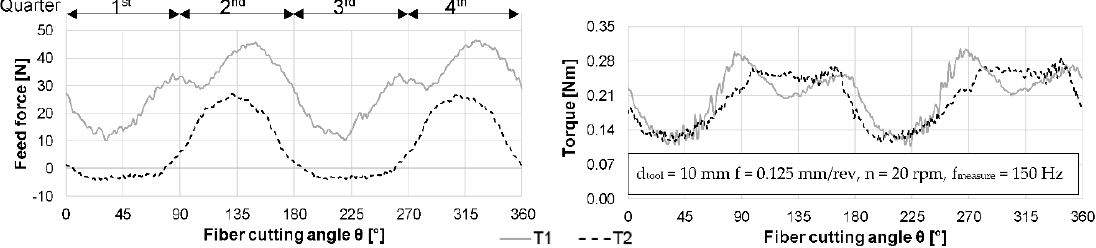
Figure 2. Comparison of feed force ( left ) and torque ( right ) during drilling with pilot bore using two different tool geometries. Contrary to the research results of other researchers [13], the higher feed force was measured at the drill with lower point angle of σ = 85°. The chisel edge cannot influence the feed force progression because the bores were drilled with a pilot bore of d pilot = 1.2 mm. The basic level of feed force of the drill is higher with a smaller rake angle. The general course of the feed force and torque graphs can be explained as follows: With a large rake angle γ , such as on tool T2, the major cutting edge grips under the fibers at θ = 0° , creating a small leading crack. The fibers run over the rake face and cause a negative feed force. This mechanism can be used to reduce delamination when the drill bit exits at a defined fiber cutting angle. Thus, the feed force would orient into the composite material that would support itself. Due to the described properties, the large rake angle is difficult to handle at the bore entrance. The cutting wedge peels up the first layer and encourages delamination at the drill entrance. In the 2nd quarter the fibers are preloaded according to Pfeifroth [2], that is, the fibers are bilaterally clamped. The reduced stiffness across the fiber direction and the resulting spring back effect of the composite ensure an increase in feed force up to θ < 135°. In this range, the preload is dissolved by cutting on one side. The preloaded fibers can be separated more precisely by the cutting edge because they are fixed at both sides. This results in a high torque and good surface quality. The